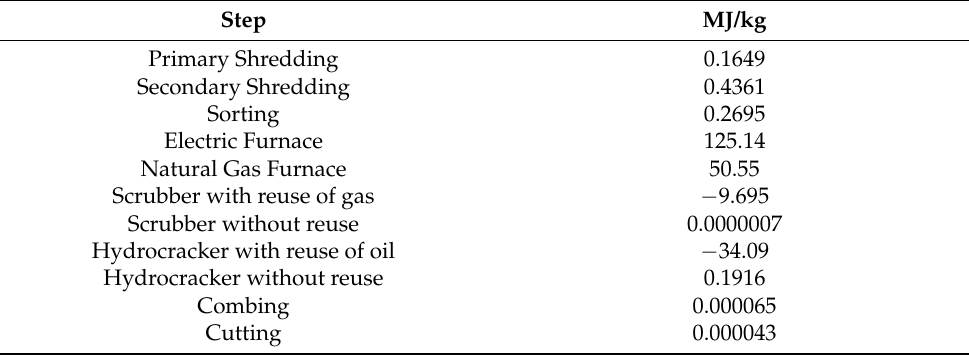
Table 2. Total EE per step within the pyrolysis process.